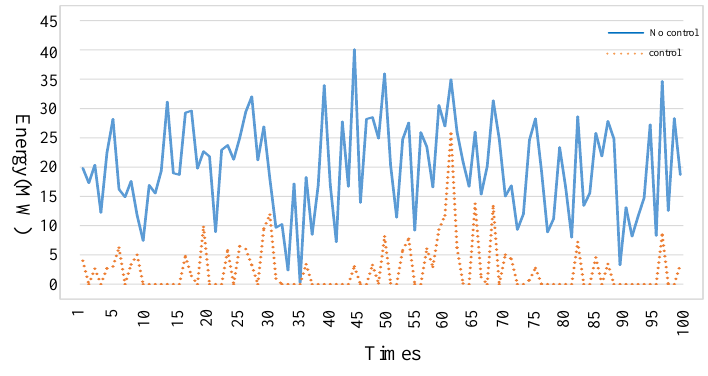
Figure 16. Results before and after control.